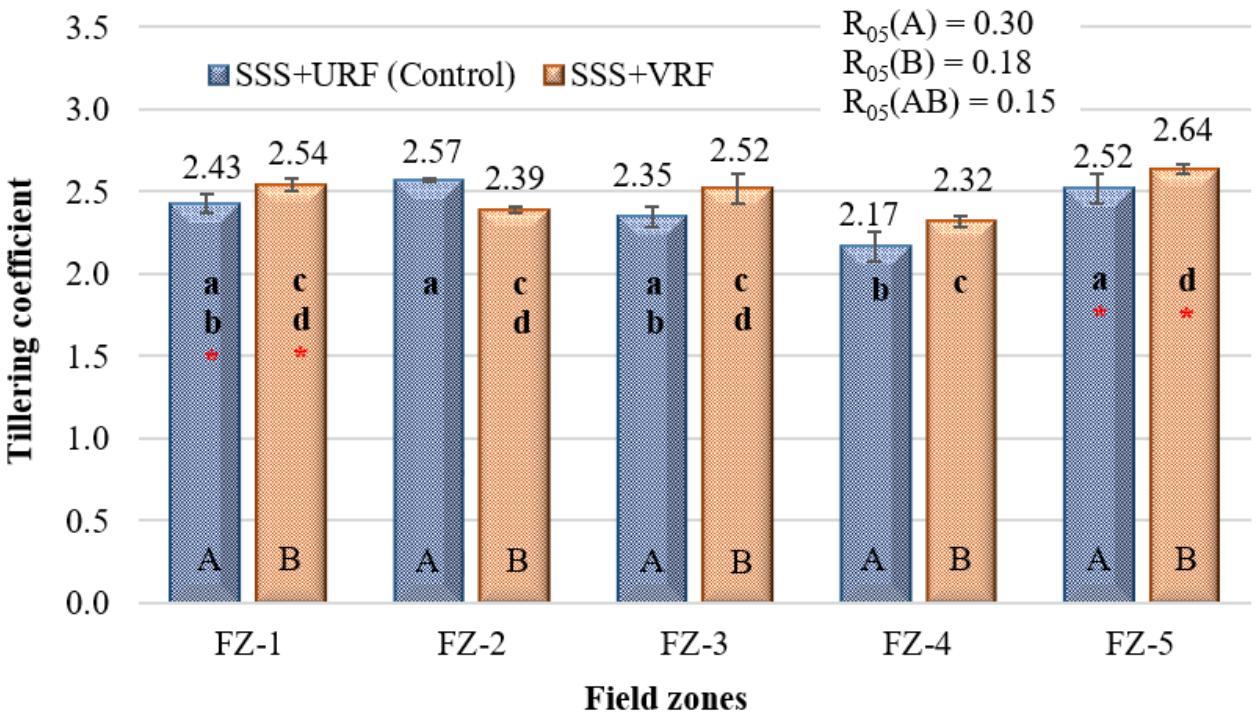
Figure 3. The effect of fertilization methods on the tillering coefficient of winter wheat in different field zones. Black letters (a, b, c, and d) indicate no significant difference between field zones for individual fertilization methods; red symbol (*) indicates no significant difference between fertilization methods in individual field zones.